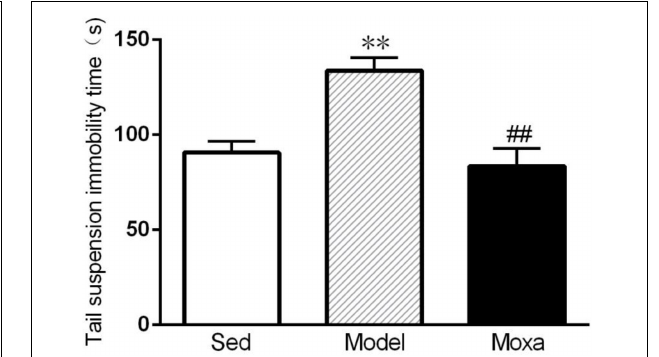
FIGURE 3 | Tail suspension immobility time in the following groups ( N = 8 per group): Sedentary (Sed), Model, Moxibustion (Moxa). Data are means ± SEM. ∗∗ P < 0.01 as compared with the Sed group, ## P < 0.01 as compared with the Model group.